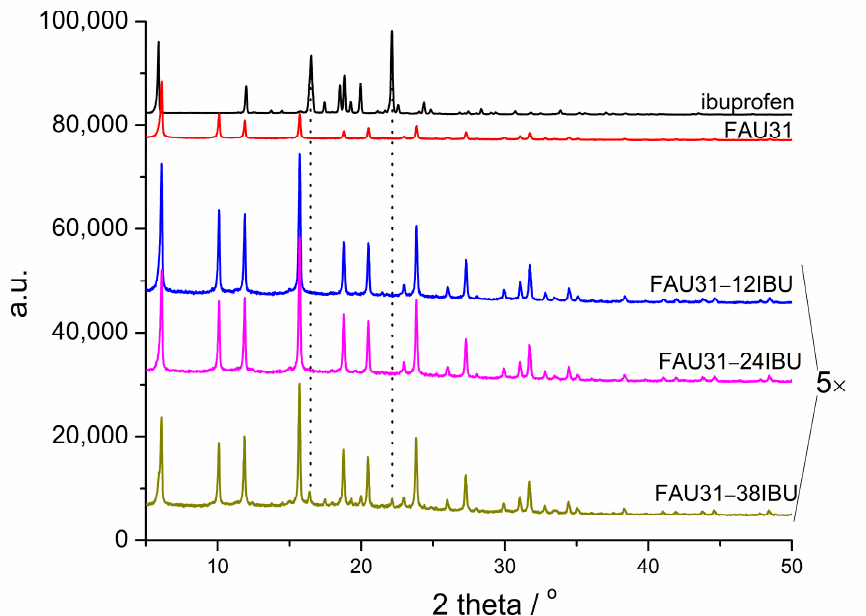
Figure 1. XRD diffraction patterns of the samples under study. For a clearer picture, patterns signed ‘5 × ’ are magnified 5 times.